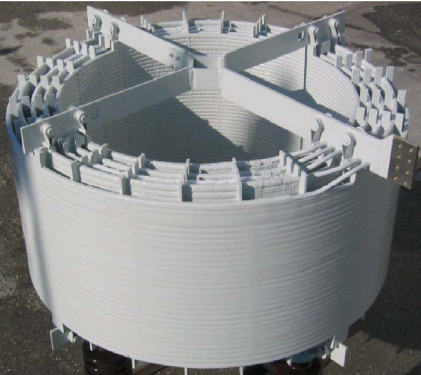
Figure 1. Industrial dry-type air-core reactor with four con- centric